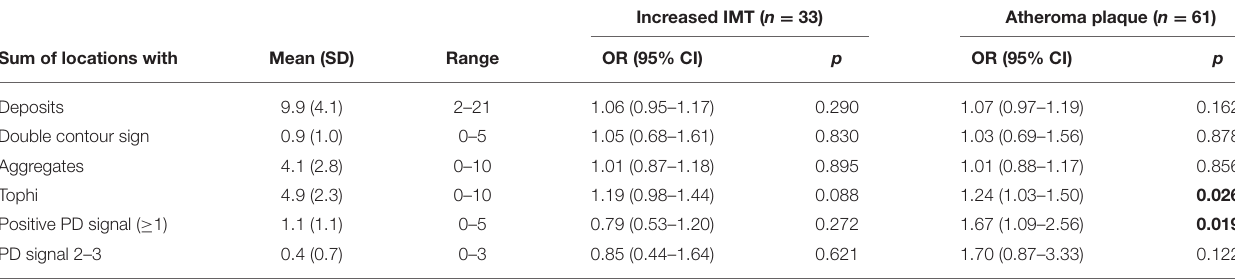
TABLE 2 | Musculoskeletal ultrasound findings and their association with carotid atherosclerosis.